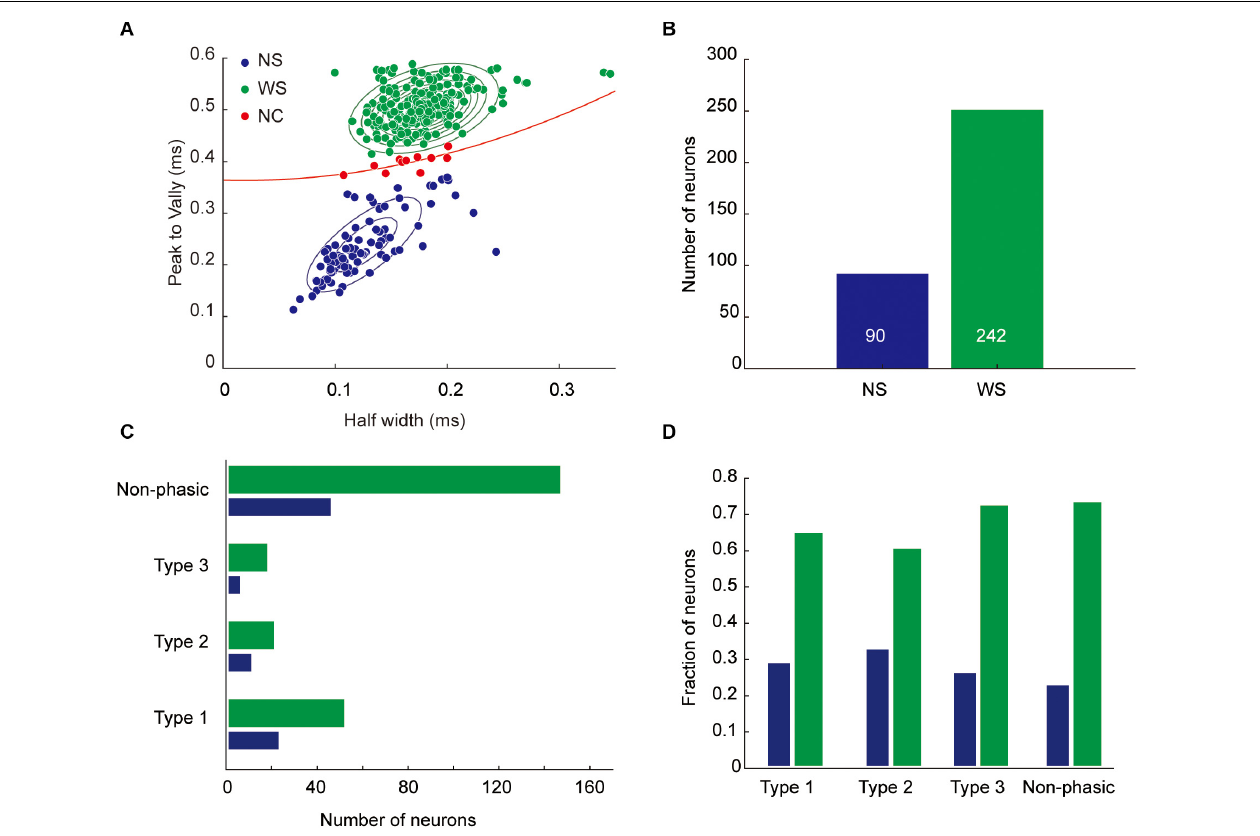
FIGURE 6 | Classification of recorded neurons based on spike waveforms. (A) Units were classified as wide-spike (WS) neurons (green circles, putative pyramidal cells) or narrow-spike (NS) neurons (blue circles, putative interneurons) based on the shape of the spike waveform. For the classification, a Gaussian mixture model was fitted to the units. Units close to the separatrix (dashed red line) with low classification confidence ( p > 0.05, red circles, n = 10) were not classified (non-classified, NC). (B) Number of neurons in each class. (C) Number of classified neurons in each task-related category. (D) Proportion of classified neurons in each task-related